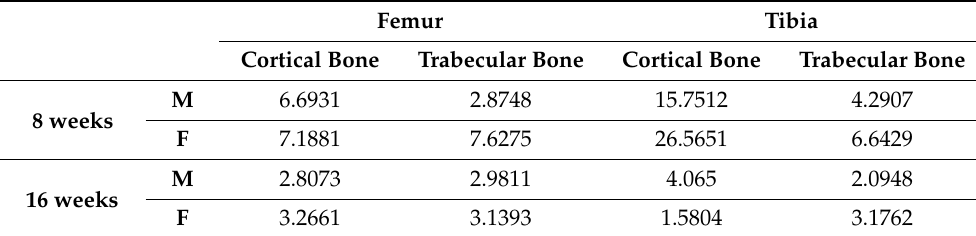
Table 2. Values of Hedges’ g , comparing Bmp3 − / − and WT mice, for normalized bone volume (BV/TV). Femur Tibia Cortical Bone Trabecular Bone Cortical Bone Trabecular